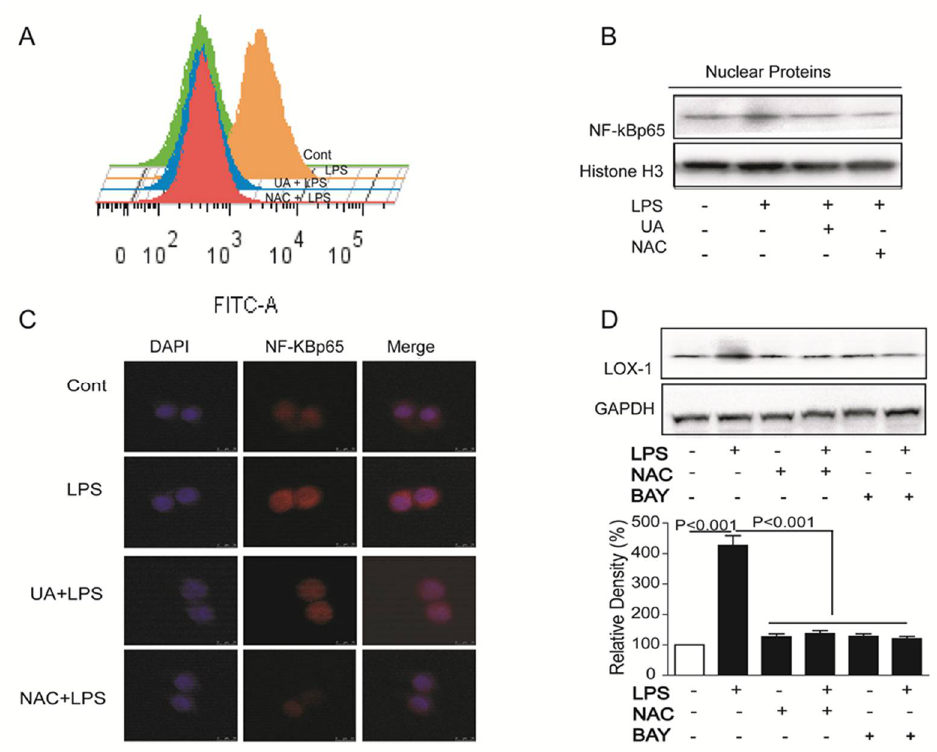
Figure 3. Cells were treated with LPS (5 mg/mL) for 4 h after pretreatment with UA (1 μM) or NAC (5 mM) for 1 h; ROS was determined by DCFH 2 -DA ( A ); Cells were treated with LPS (5 mg/mL) for 24 h with or without pretreatment with UA (1 μM), NAC (5 mM), or BAY (10 μM) for 1 h, and expression of p65 ( B ) and LOX-1 ( D ) was detected by western blotting; Cells were treated with LPS (5 mg/mL) with or